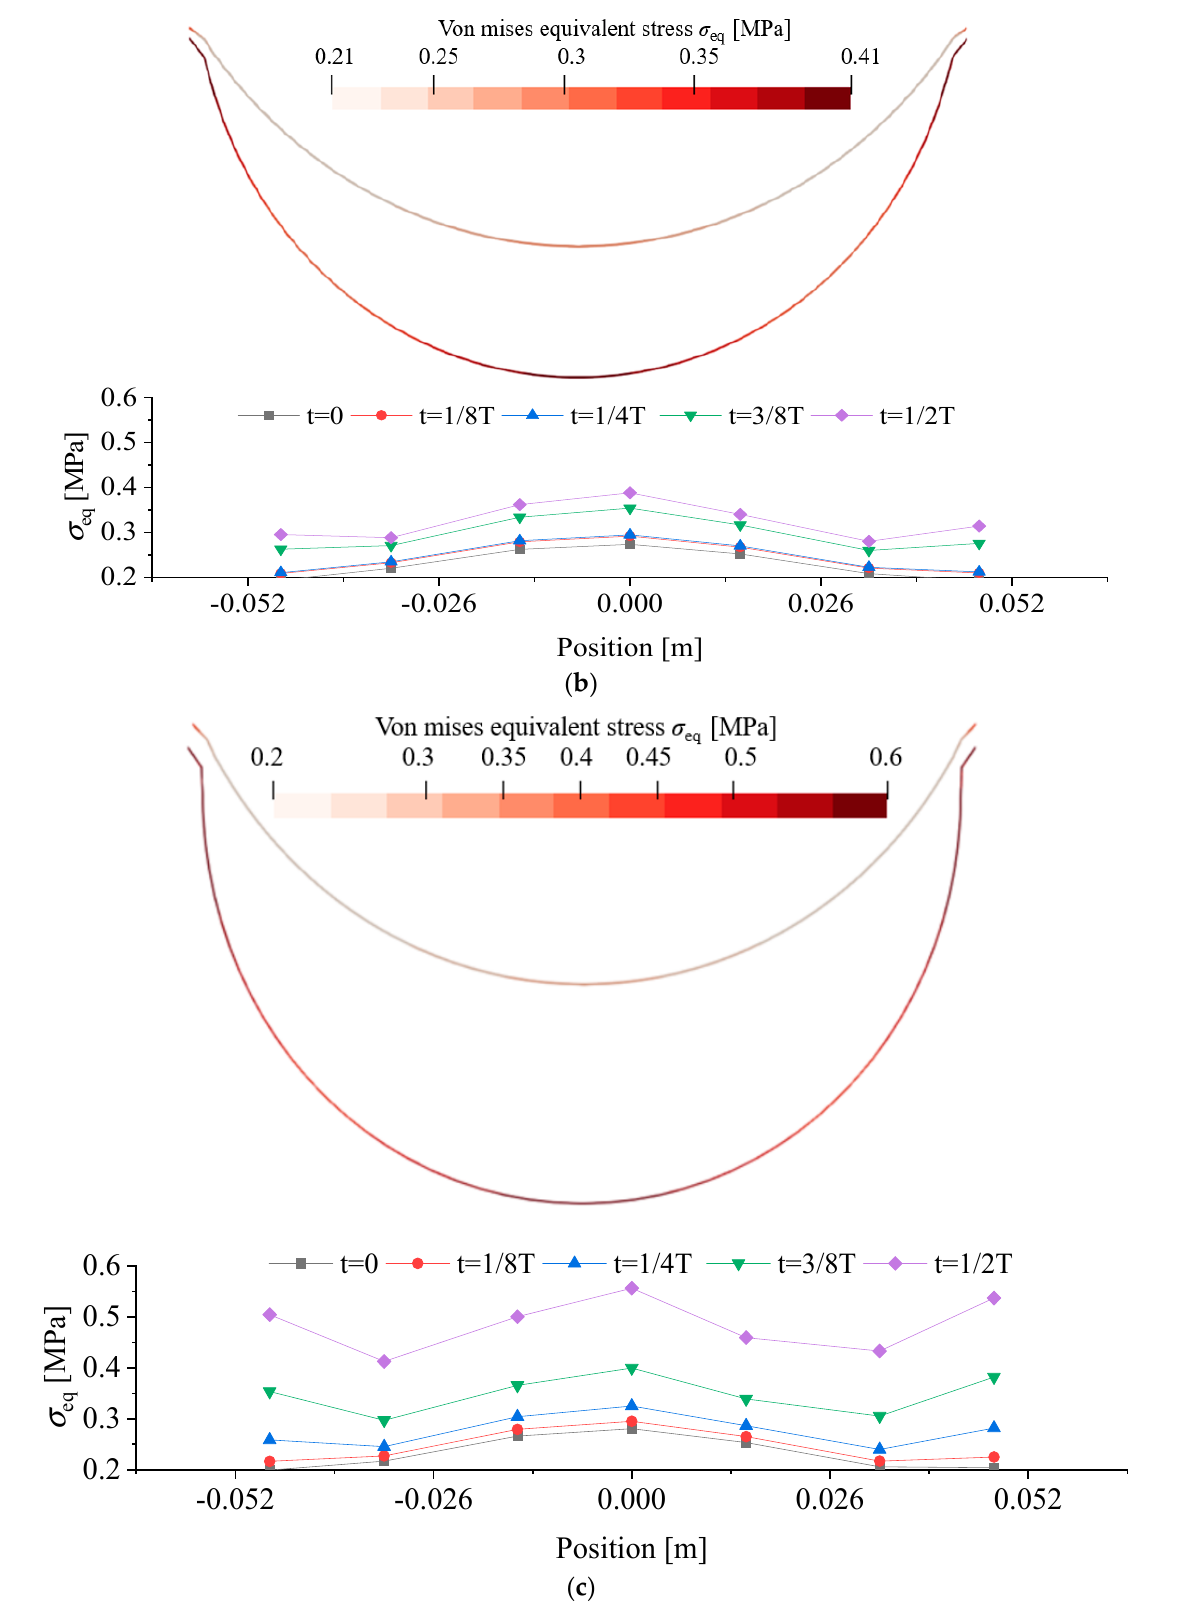
Figure 17. The maximum and minimum deformations of the membrane and the distribution of equivalent stress σ eq along the membrane: ( a ) linear-elastic, ( b ) hyper-elastic M3, and ( c ) hyper-elastic M4 materials.